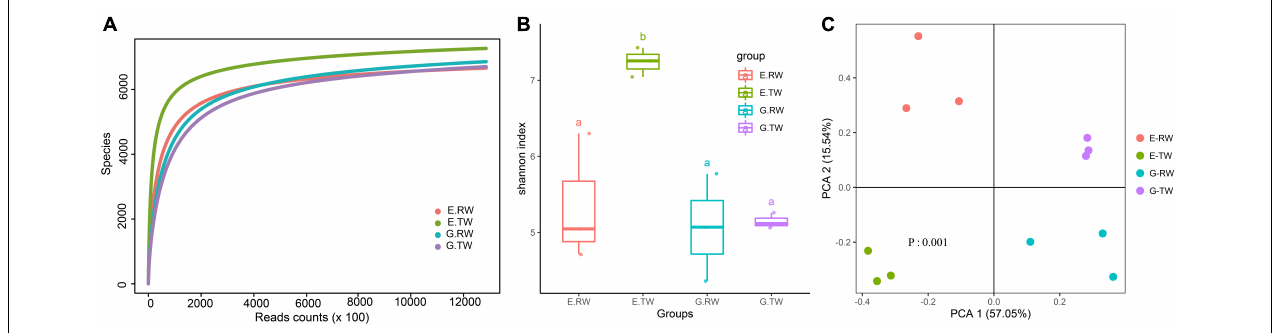
FIGURE 2 | Alpha and beta diversity of microbial community. (A) Rarefaction curves of genus level. (B) Alpha diversity of four groups measured by Shannon diversity index. (a: No significant difference; b: significant difference) (C) Beta diversity of four groups measured by the PCA.